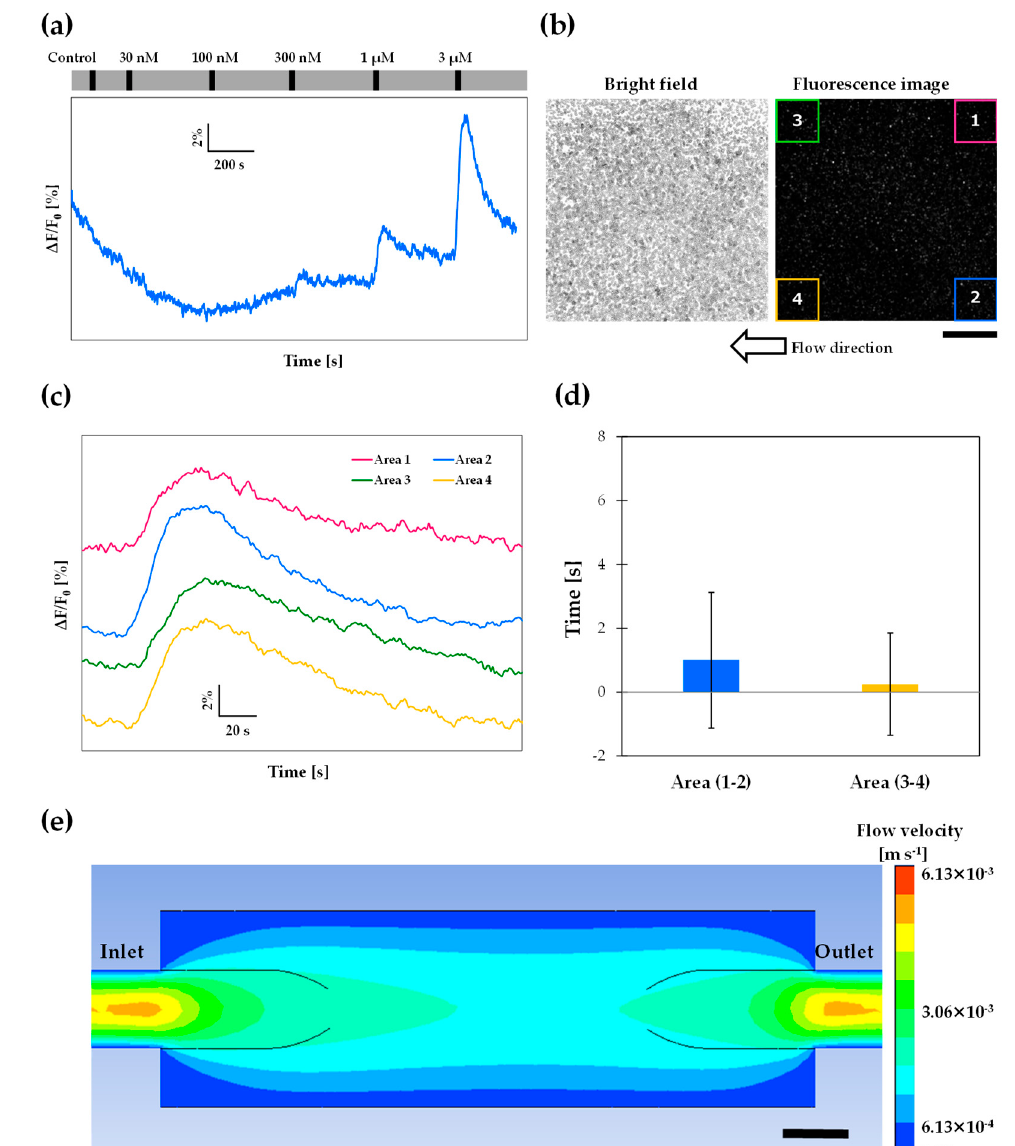
Figure 6. ( a ) Typical dose–response profiles of fluorescence intensity changes in Or13a cells in the 3D-printed cartridge using a 4× objective lens during the addition of 1-octen-3-ol at concentrations ranging from 30 nM to 3 μ M. The long grey bar indicates the perfusion of the assay buffer solution including 0.1% DMSO by peristaltic pumps. ( b ) Bright field and baseline fluorescence images of Or13a cells observed by a 4× objective lens. ( c ) Each point of fluorescence intensity change in ( b ) observed by a 4× objective lens. The size of each observation field is 400 × 400 μ m 2 . ( d ) Difference between response times of Area 1 and Area 2, and differences between response times of Area 3 and Area 4 stimulated by 3 μ M 1-octen-3-ol. Data represent the mean ± SEM of calculated time differences between response time of each 400 × 400 μ m 2 area ( N = 4 individual tests). ( e ) CFD simulation result of flow velocities in the 3D-printed cartridge. These velocities of the cross-sectional view of B–B direction in Figure S1, Supplementary Materials. ( e ) is represented as a contour. Scale bars: ( b ) 500 μ m; ( e ) 1 mm.